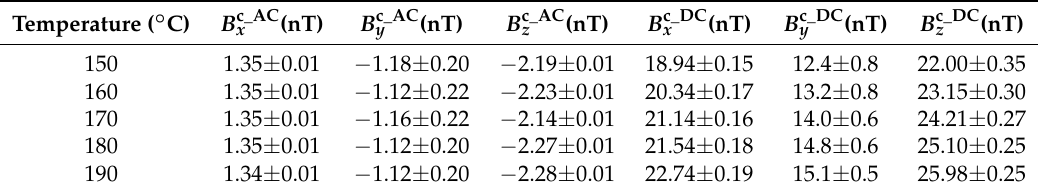
Table 1. Compensation magnetic field in the AC heating mode ( B c mode ( B c ) at different cell temperatures. The sign indicates the direction of magnetic DC